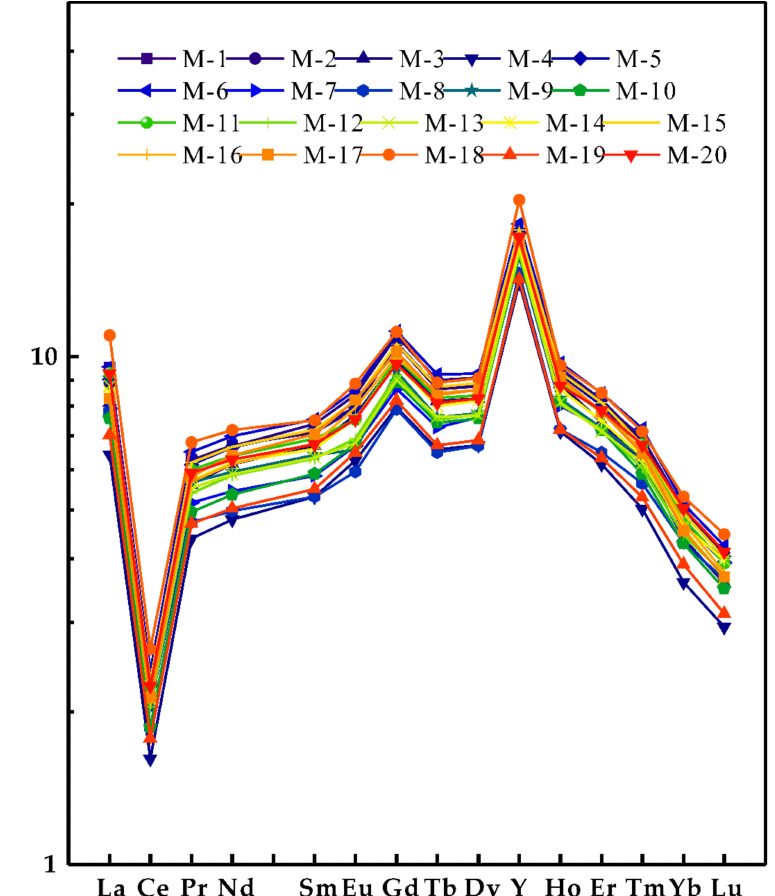
Figure 5. Post-Archean Australian Shales (PAAS)-normalized REY patterns of apatite in this